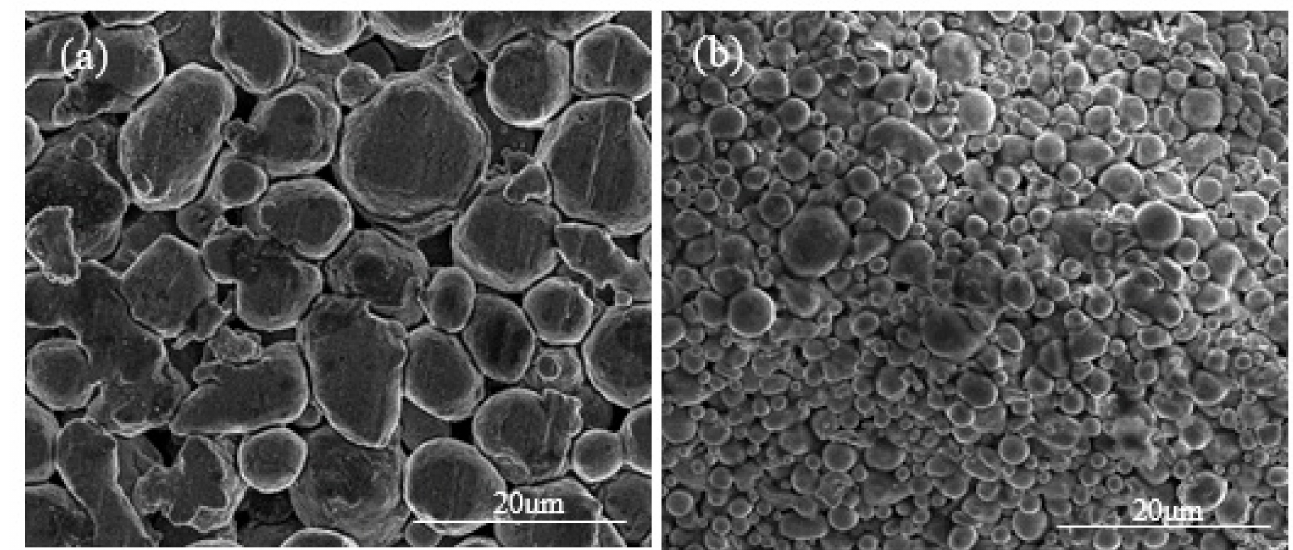
Figure 6. The microstructure of the specimens after debinding. ( a ) Al7075 with wet-mixing powders (two-step thermal debinding). ( b ) FDM 17-4 steel specimen (chemical washing and thermal